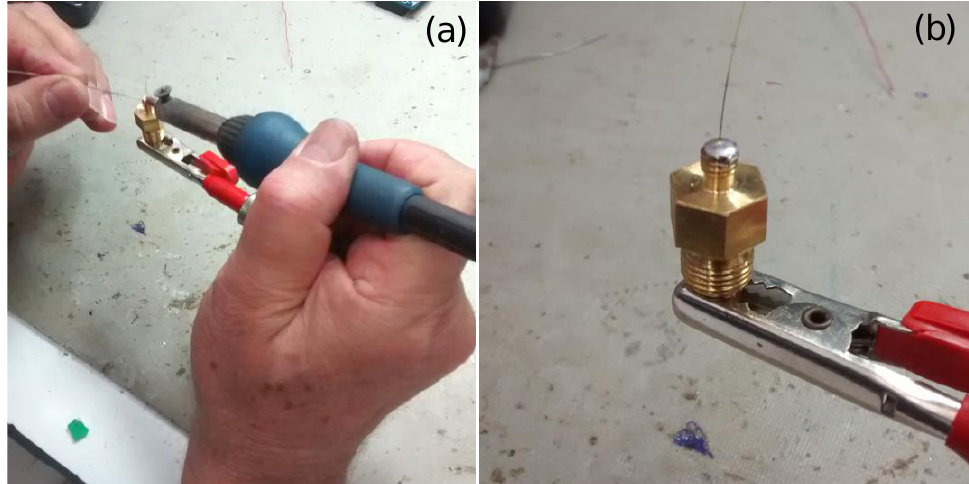
Figure 6. ( a ) Soldering the gold metalized fiber in the pressure connector and ( b ) the pressure connector sealed with HMP and exhibiting the optical fiber.